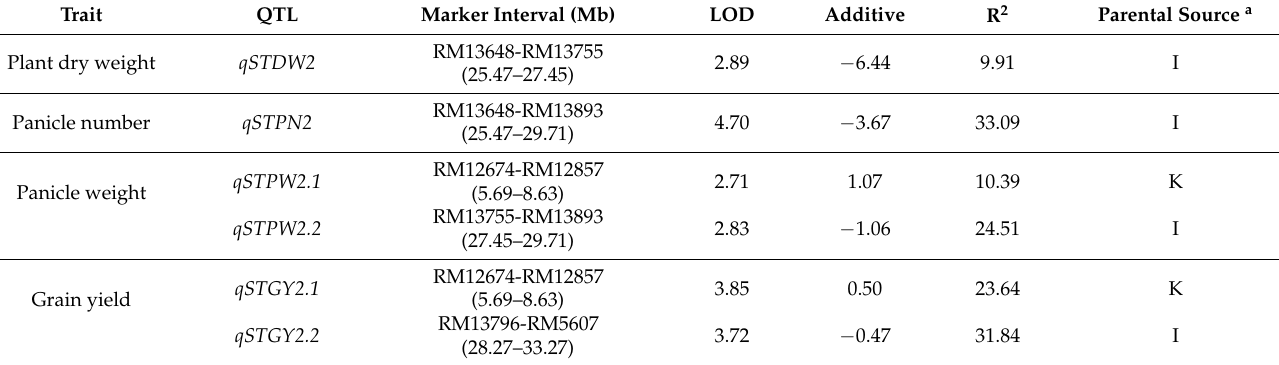
Table 3. Quantitative trait loci (QTL) for grain yield and yield-related traits identified in the F 2 population by composite interval mapping on chromosome 2.